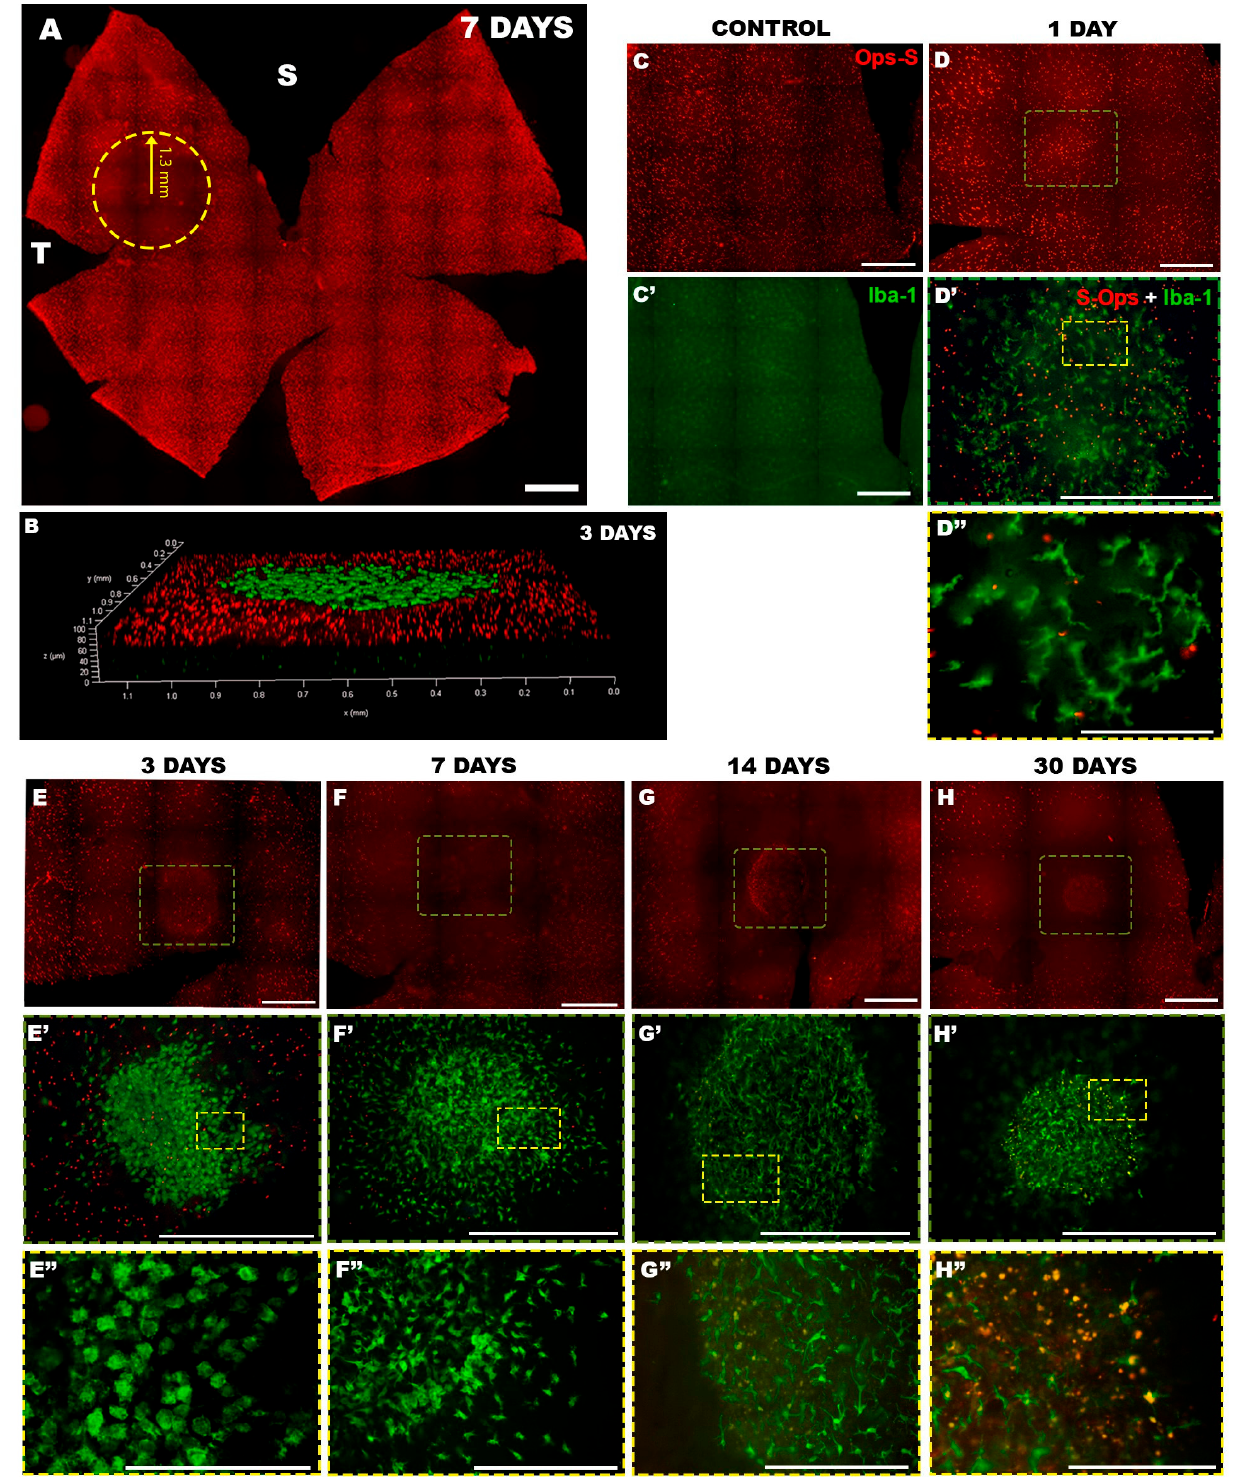
Figure 2 . Progressive S-cone loss parallels activation of Iba-1 + cells in the focal area of lesions after LIP. LIP results in a progressive loss of S cones in a focal injured area located in the superior-temporal retina ( A ). This loss was accompanied by activation of Iba-1 + cells within the lesion area in the OS layer ( B ). Panels ( C – H ’’) show the status of S cones (labelled with Opsin S) and Iba-1 + cells in the OS layer in a non-photoexposed control fellow retina ( C , C ’) and in photoexposed experimental retinas analysed at days 1 ( D – D ’’), 3 ( E – E ’’), 7 ( F – F ’’), 14 ( G – G ’’), or 30 ( H – H ’’) after LIP. S: superior; T: temporal. Scale bar in A = 1 mm. Scale bar in (C–H') = 500 µm. Scale bar in (E''-H'')= 100 µm. By 3 days, the lesioned area had progressed with an evident loss of S-opsin + OS to- gether with a colocalisation of an increased number of microglial cells in the centre of the lesion. These microglial cells appeared with well-rounded cell bodies containing vacuoles,